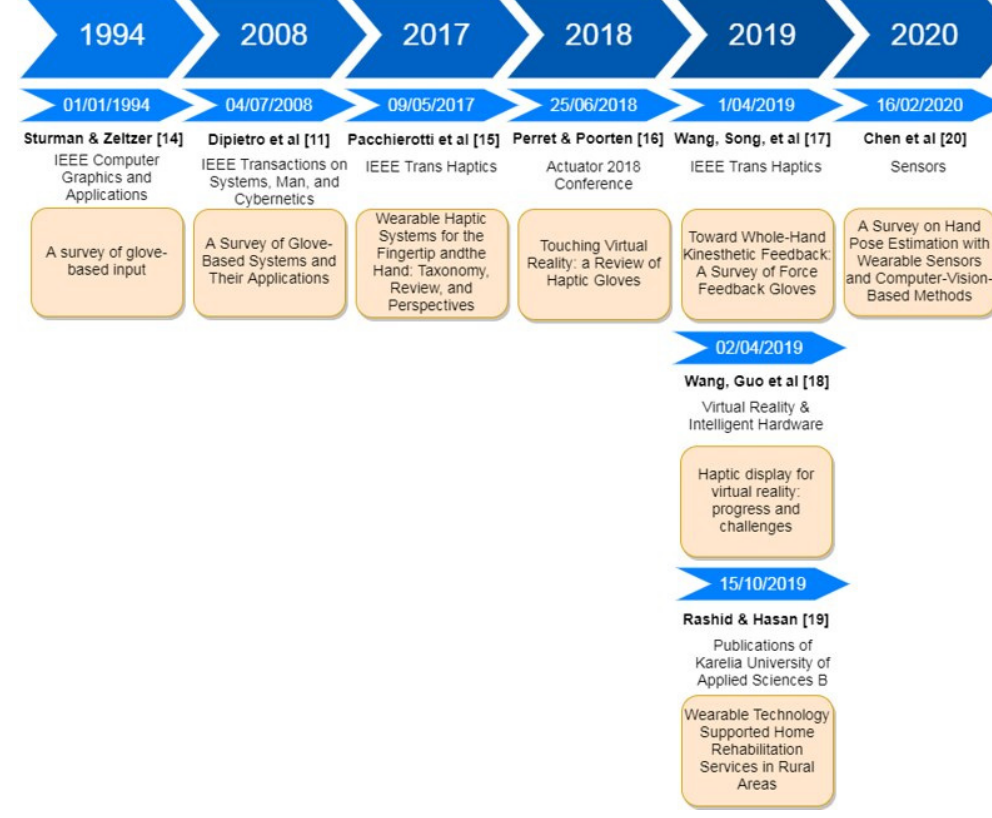
Figure 5. Published reviews about smart gloves timeline.